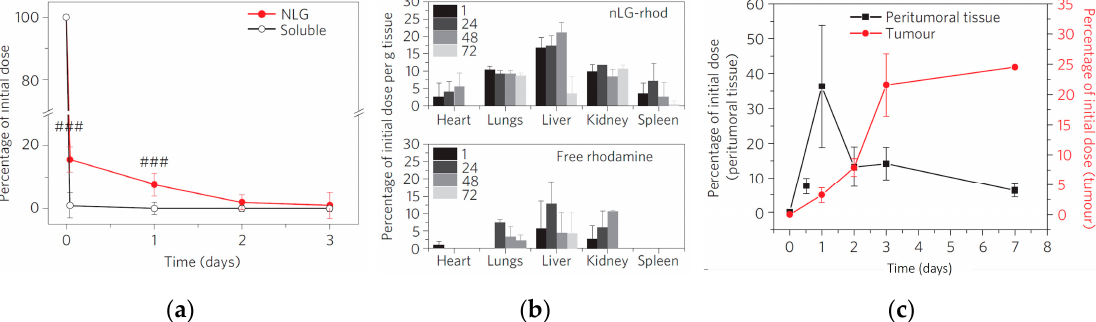
Figure 9. In vivo biodistribution data: ( a ) Persistence in the blood stream of free and loaded rhodamine (### denotes P < 0.01 in the two population t-test); ( b ) cumulative biodistribution of free and loaded rhodamine (the legend denotes the post-injection hours); and ( c ) accumulation of rhodamine (delivered by the nanolipogel) in the tumoral tissue and residual amount in the peritumoral region. Error bars in all plots represent ± std. dev. Reprinted by permission from Springer Nature: Nature Materials [79], Copyright 2012.